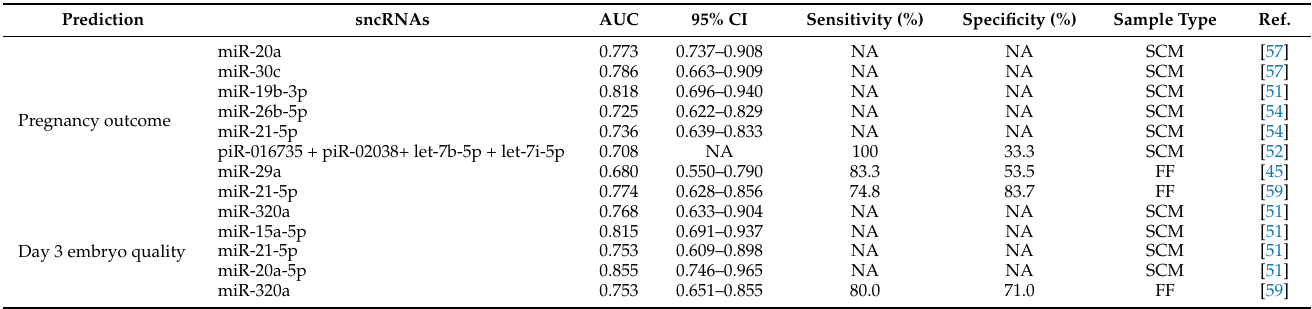
Table 4. Summary of predictive ability of differentially expressed sncRNAs in various